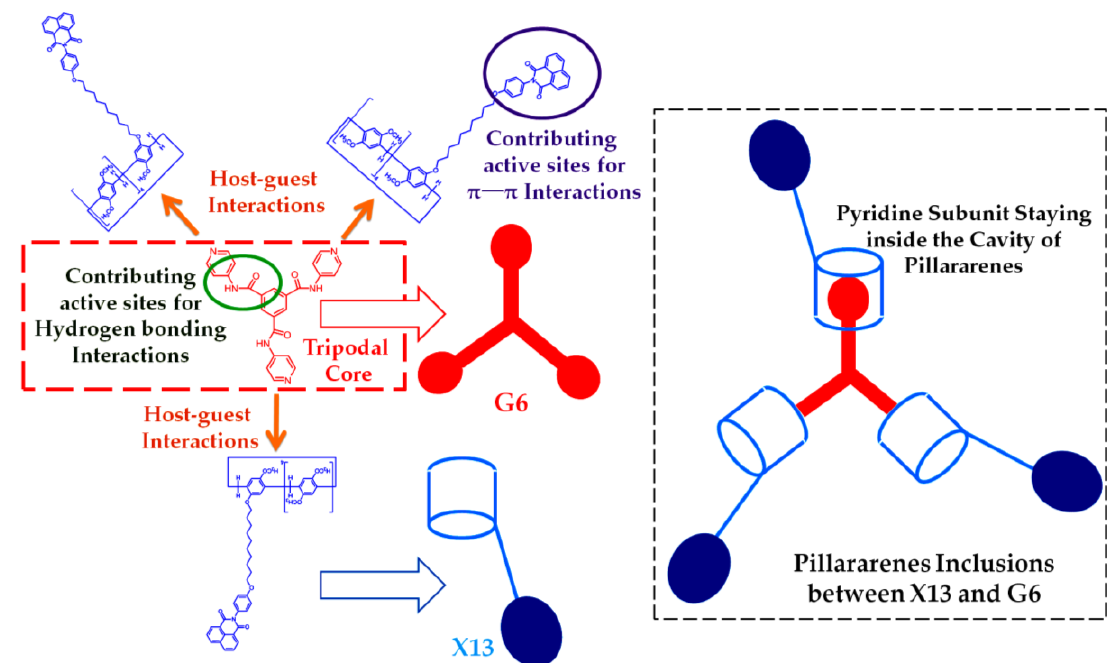
Figure 1. Proposed assembly mechanism of supramolecular inclusions X13 ⊃ G6 by noncovalent bonds [28].